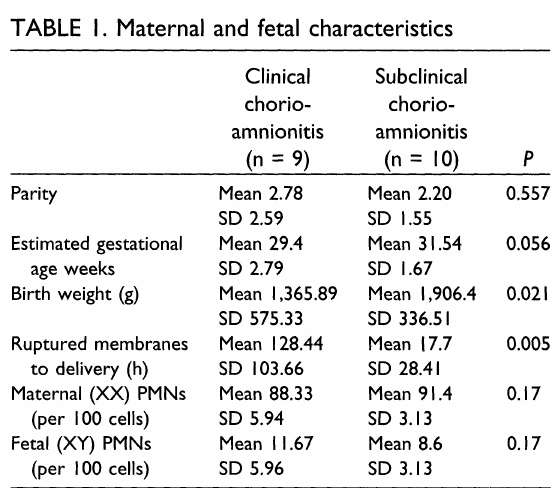
TABLE I. Maternal and fetal